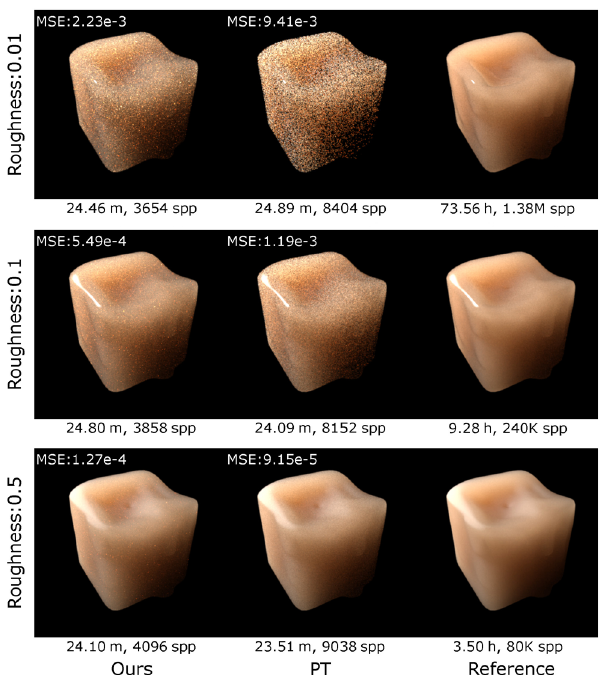
Fig. 20 Comparison between our method and path tracing with equal time on the Candle scene with varying surface roughness.